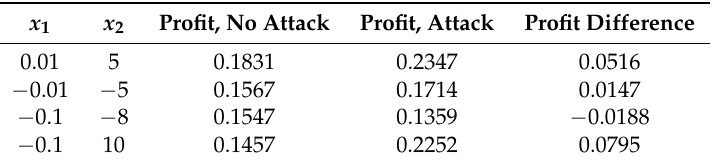
Table 6. Profit results for four different initial conditions with and without cyberattacks over a sampling period, with ρ (cid:48) =